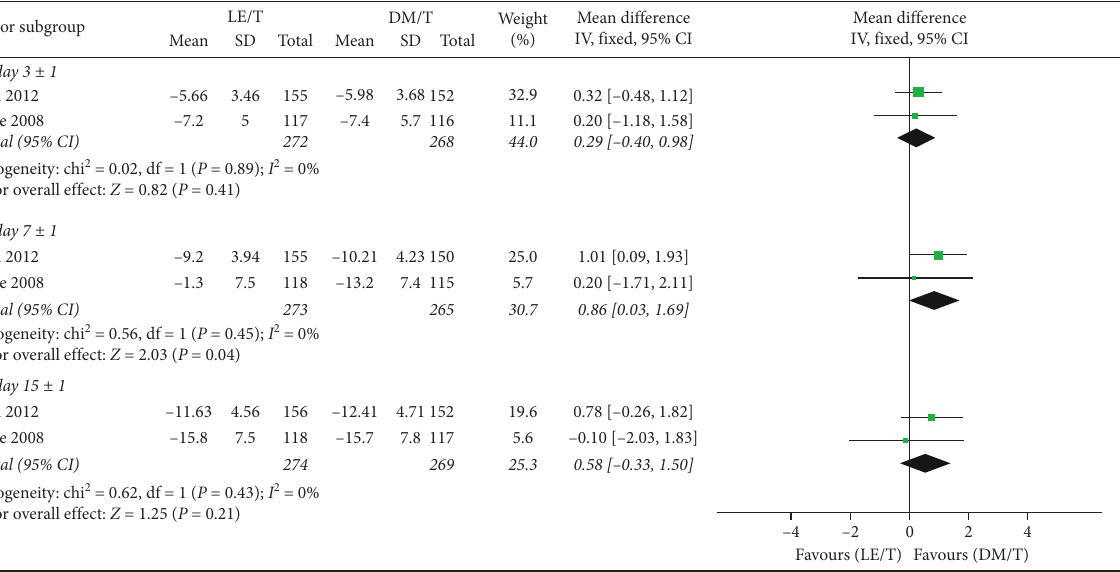
Figure 4: Forest plot of CFB in the ocular signs and symptoms composite score.